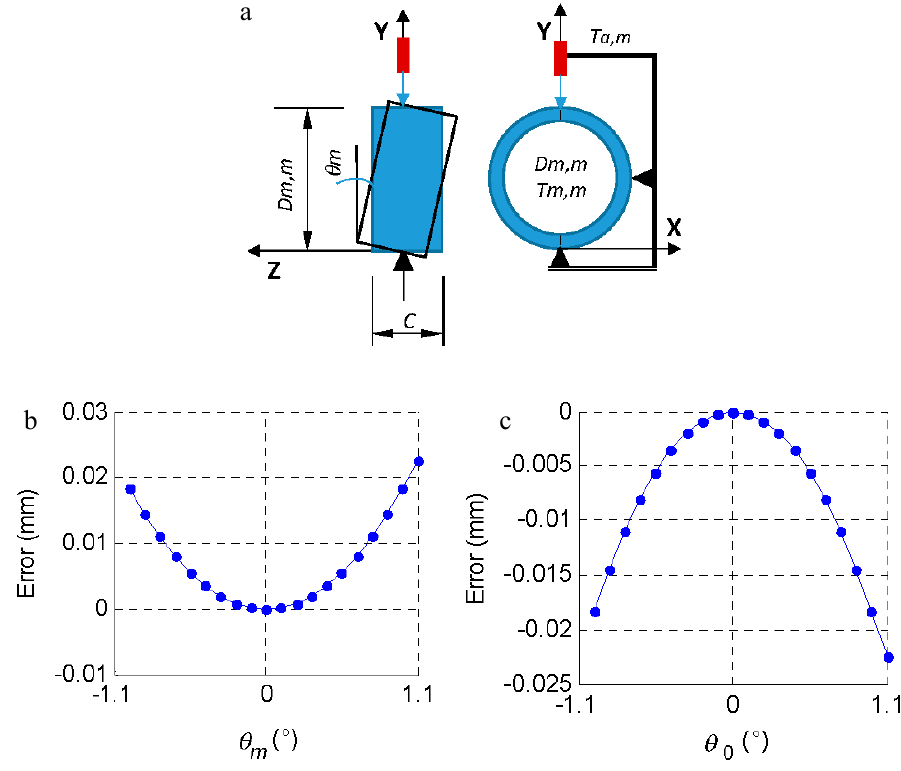
Figure 4. ( a ) θ m , inclination of the piece when it is placed in the measuring tool. ( b ) Effect of the inclination of the m -th part ( θ m ) on the measurement error (comparator reading— D m,m ). ( c ) Effect of the inclination of the masterpiece ( θ 0 ) on the measurement error (comparator reading— D 0,0 ).